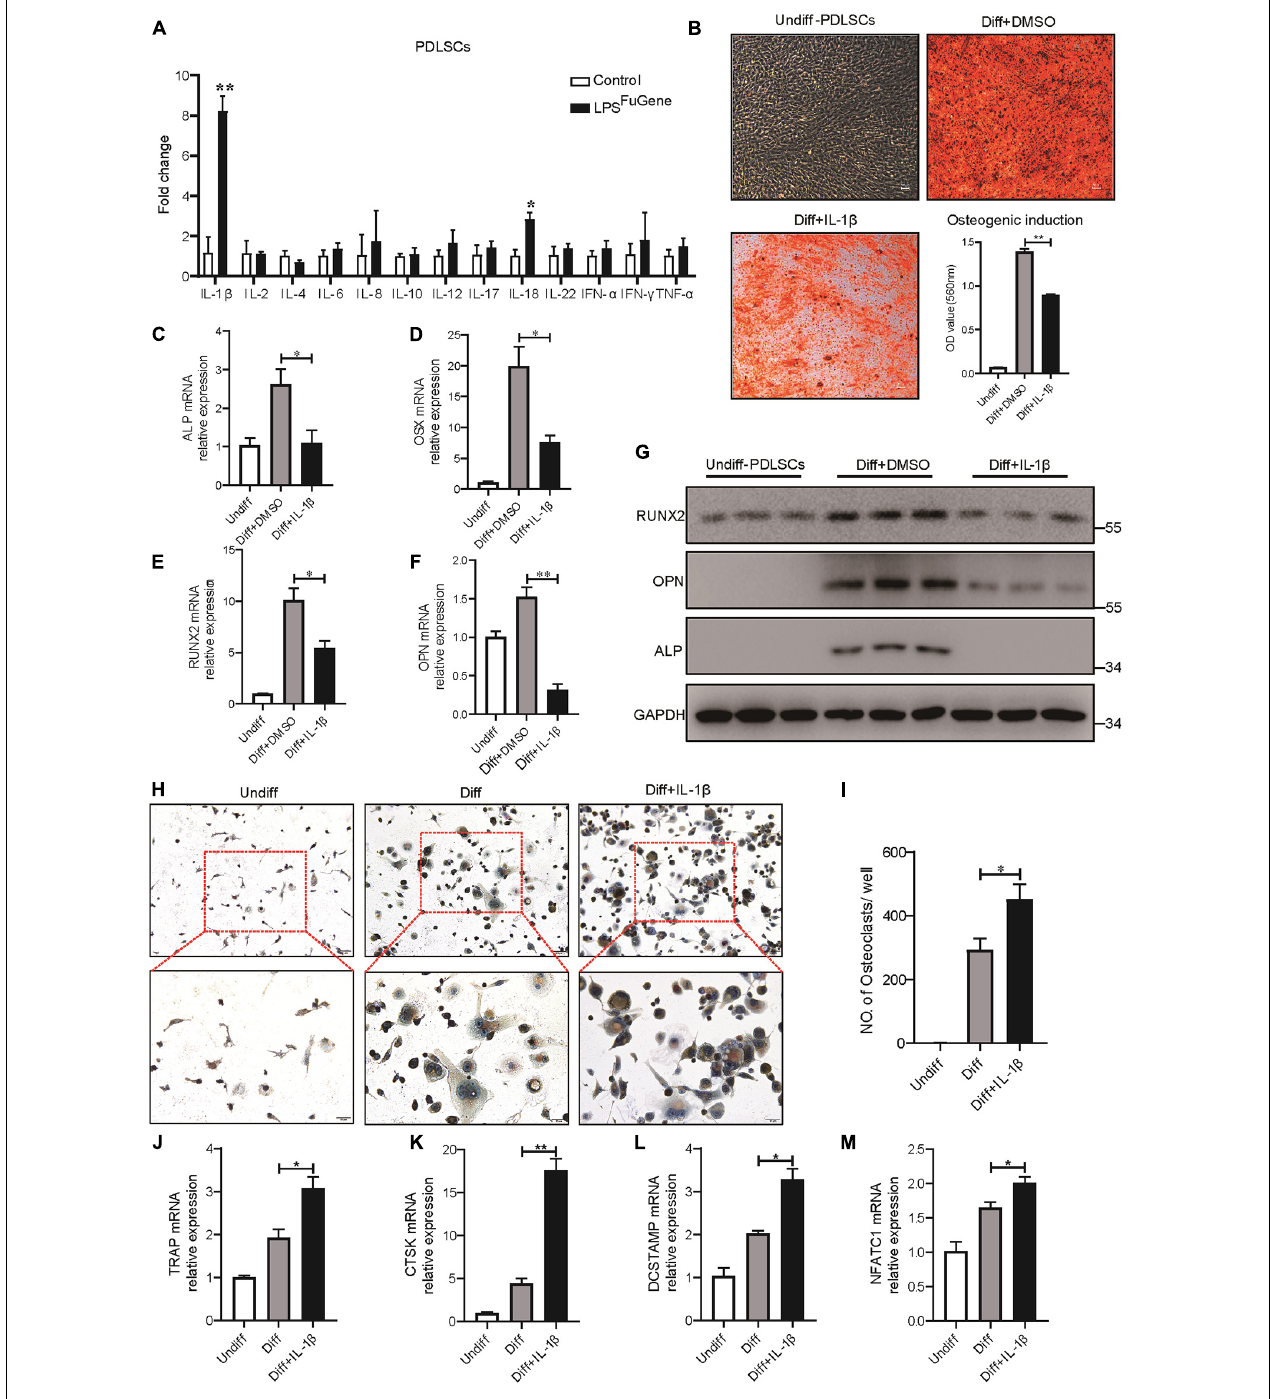
FIGURE 5 | IL-1 β was the key factor in PDLSC pyroptosis to regulate osteoblast and osteoclast differentiation. (A) Expression profiles of several inflammatory cytokines in PDLSCs under LPS FuGene treatment for 16 h. (B–G) PDLSCs were incubated with osteogenic differentiation medium for 21 days with or without 500 pg/mL IL-1 β treatment. (B) Representative images of alizarin red staining and quantification of the staining results. ALP (C) , OSX (D) , RUNX2 (E) , and OPN (F) mRNAs were subjected to real-time PCR analysis, and the expression levels were normalized to that of 36B4 . (G) Immunoblots for RUNX2, ALP, and OPN in whole-cell lysates. GAPDH was used as a loading control. (H–M) THP-1 cells were incubated with osteoclast differentiation medium for 14 days with or without 500 pg/mL IL-1 β treatment. (H) Micrographs of TRAP staining after culturing in osteoclast differentiation medium. (I) Quantification of TRAP-positive multinucleated cells (nuclei > 3). TRAP (J) , CTSK (K) , DCSTAMP (L) , and NFATC1 (M) mRNAs were subjected to real-time PCR analysis, and the expression levels were normalized to that of 36B4 . The data are presented as the mean ± SEM. * P < 0.05, ** P < 0.01.